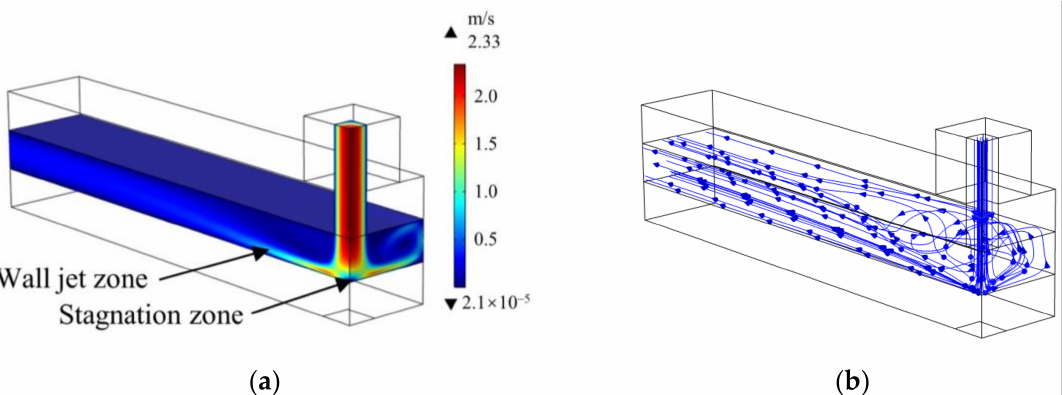
Figure 3. The velocity contour and streamlines of confined jet impingement: ( a ) Velocity distribution; ( b ) streamline